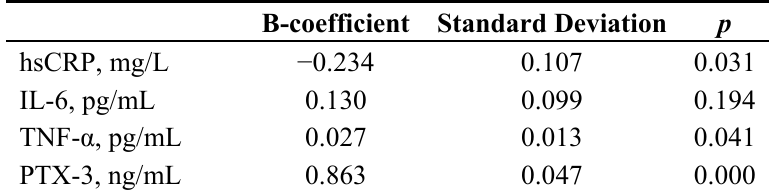
Table 3. Multivariate regression analysis to evaluate the independent predictors of carotid intima-media thickness